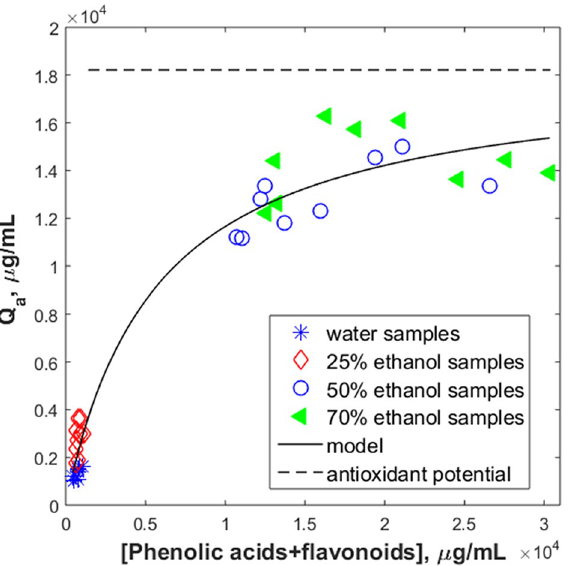
Figure 6. Antioxidant capacity as function of samples total polyphenolic derivatives